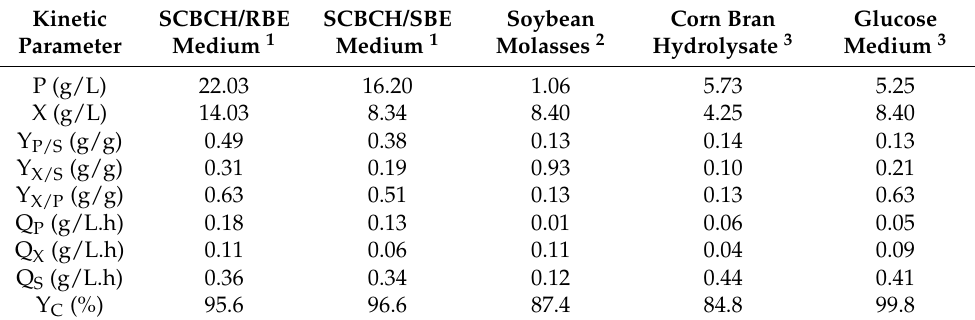
Table 1. Comparison of fermentative parameters for lasiodiplodan production on various carbon